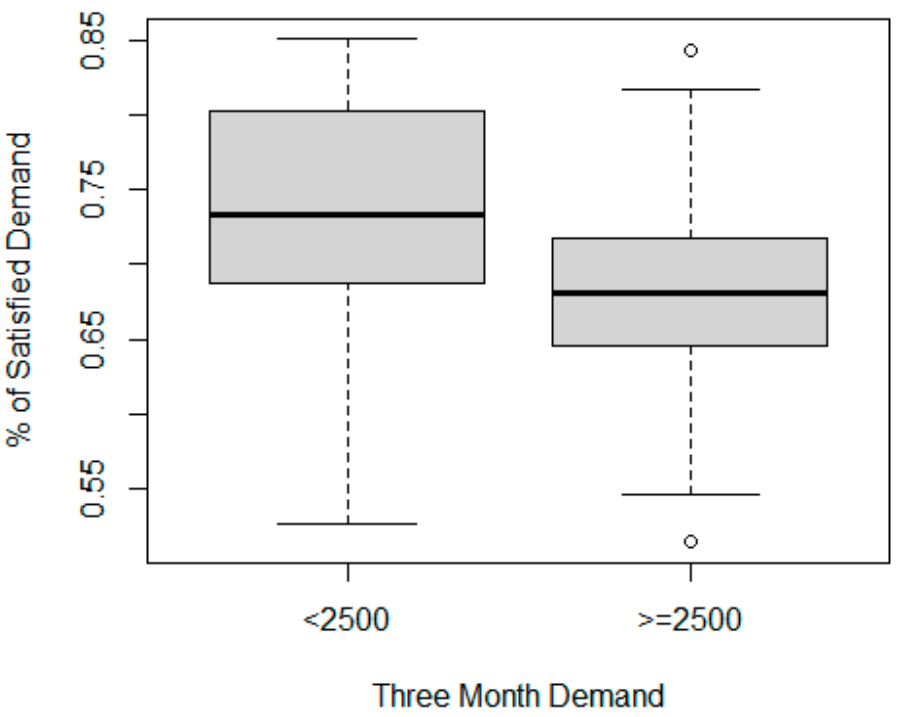
Figure 3. The effect of demand on the percentage of satisfied orders in the three-month period.